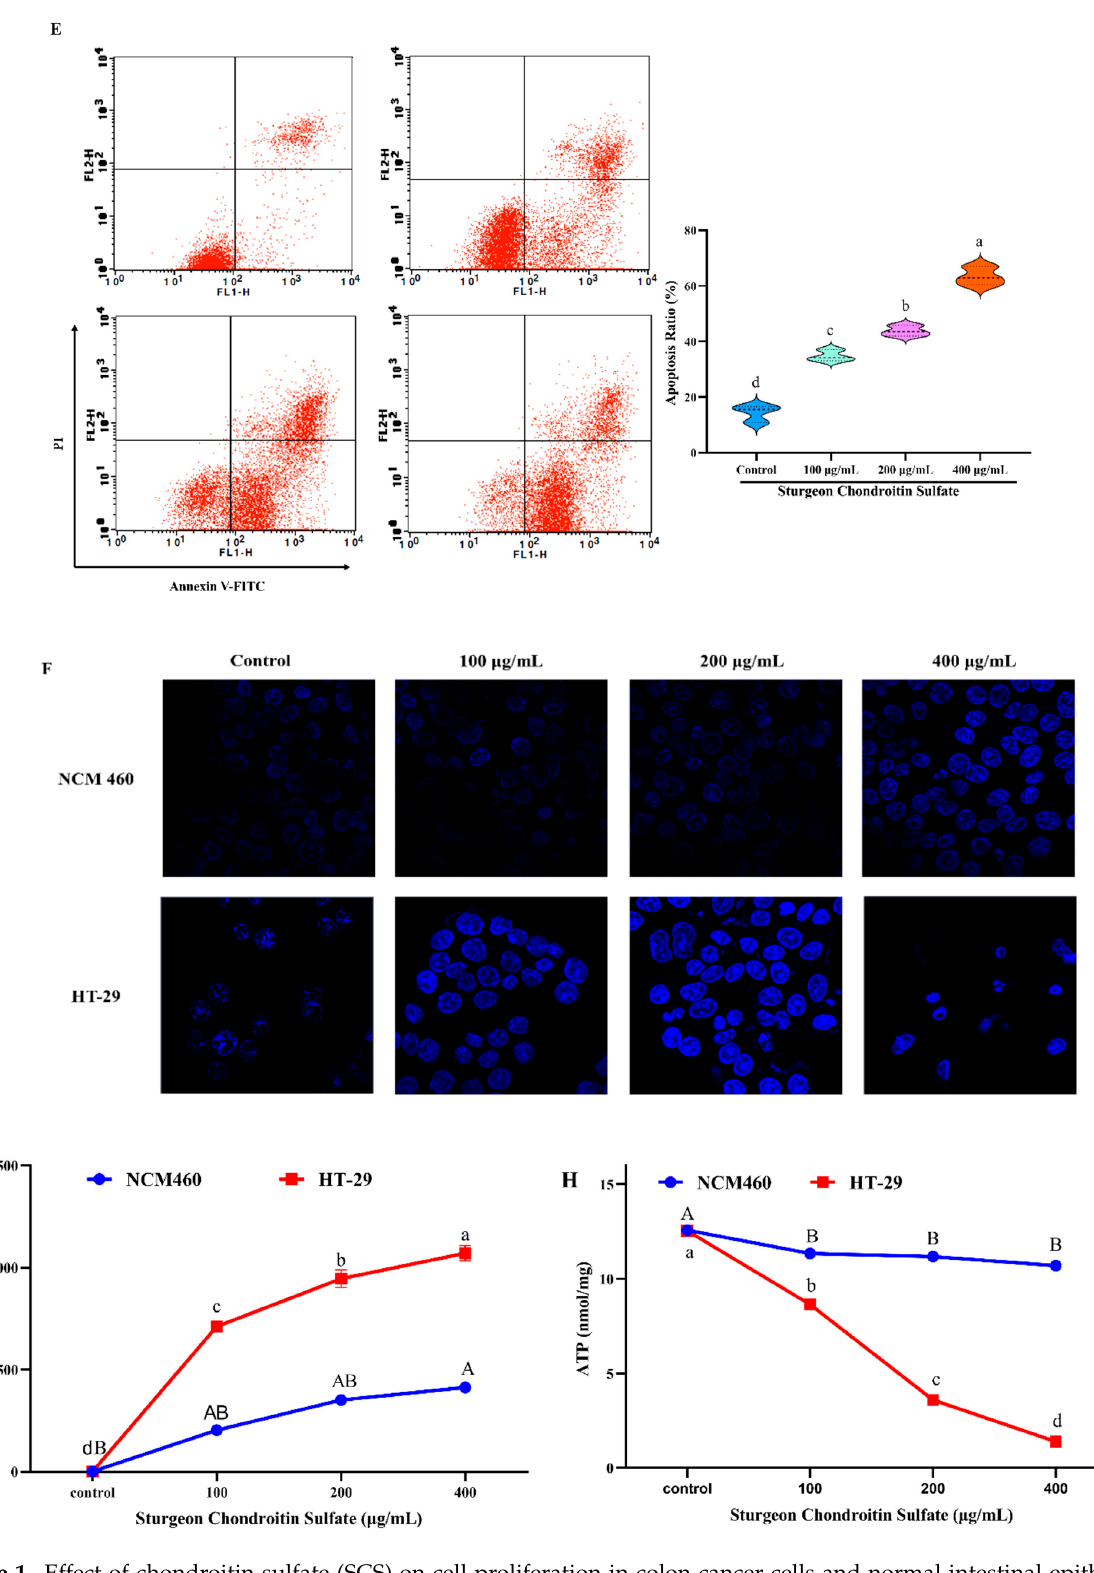
Figure 1. Effect of chondroitin sulfate (SCS) on cell proliferation in colon cancer cells and normal intestinal epithelial NCM460 cells. ( A ) Colon cancer HT-29, Caco-2, HCT-116, SE480, LS-174-T cells and normal intestinal epithelial NCM460 cells were treated with different concentration (50, 100, 200, 400, 800, and 1000 µ g/mL) of SCS and positive control cisplatin for 24 h. Cell viability was measured by CCK8 cell counting assay and the results were expressed as inhibition rate (%)